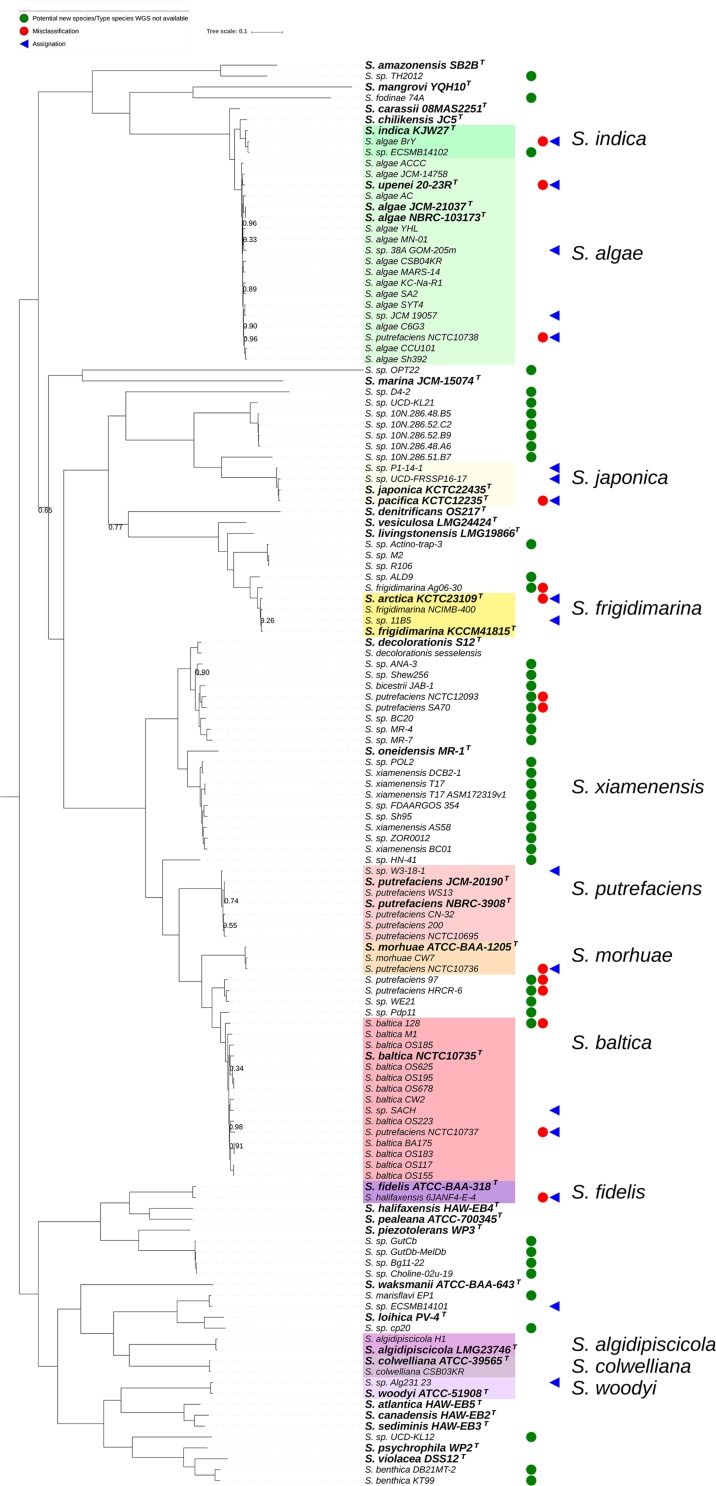
Core genome-based phylogenetic reconstruction of the genus Shewanella based on 131 publicly available whole genome sequences. Node figures indicate branch support values as determined by the Shimodaira-Hasegawa approximate likelihood ratio test (SH-aLRT). For clarity, no value is presented at nodes where SH-aLRT equals 1. Type species are indicated in bold with a superscripted T, and the major clades containing a type species and at least one additional genome are shadowed. A symbol has been assigned to highlight misclassified isolates (red circles), re-assignations at the species level (blue triangles) and potentially new species (green circles) based on the dDDH-based phylogeny presented in Figure 1.